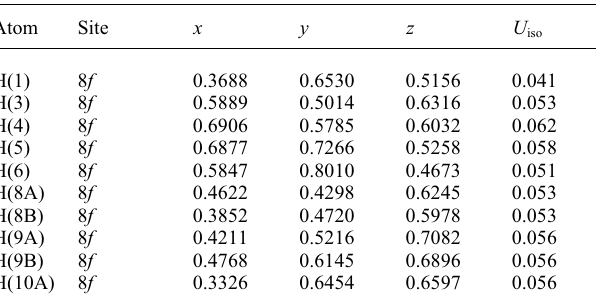
Table 2. Atomic coordinates and displacement parameters (in Å 2 )